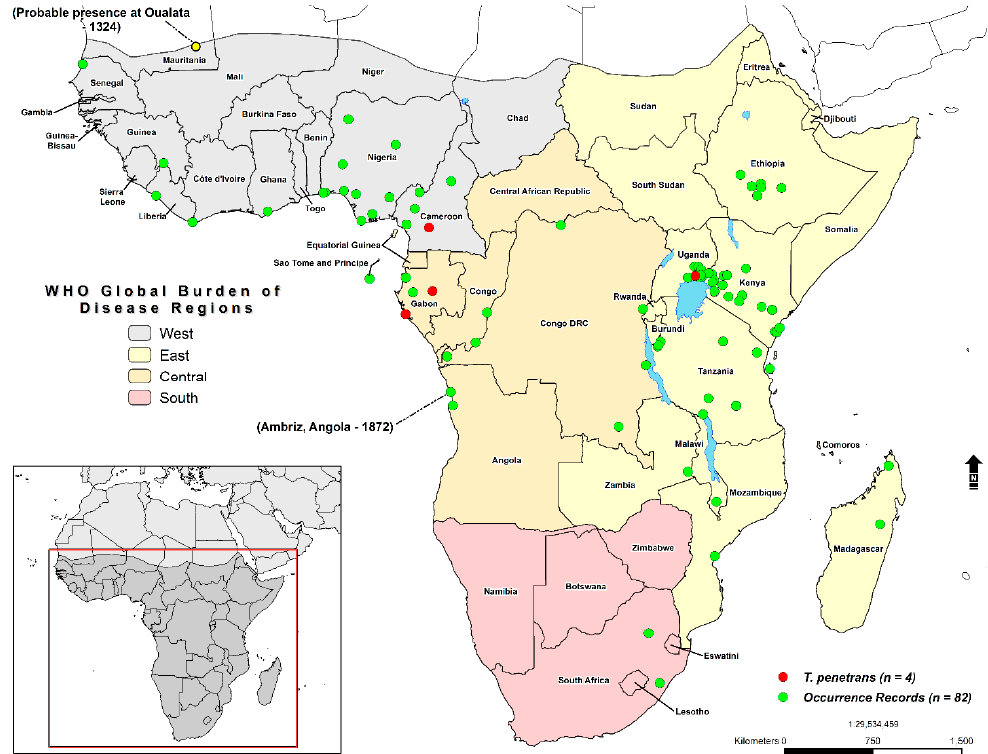
Figure 2. Model calibration region and study area defined by the WHO Global Burden of Disease Regions (GBD). Green dots correspond to occurrence locations (n = 86). The accepted historic arrival in Africa of Tunga penetrans in Ambriz, Angola (1872), and the probable presence at Oualata (1324) are highlighted.